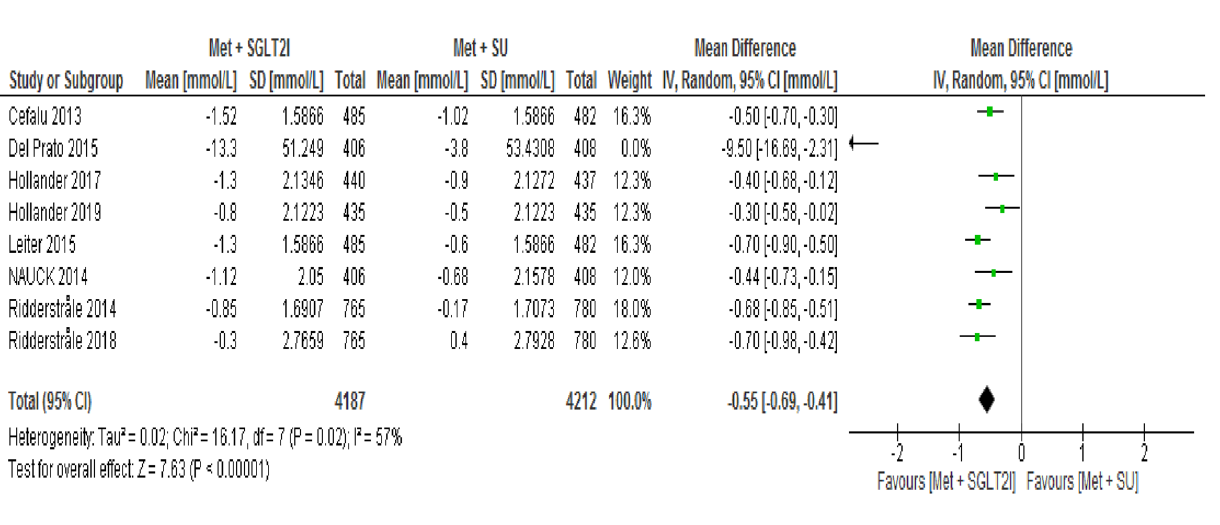
Figure 10. Comparison of change in body weight (Kg) from baseline between patients who were on metformin-SGIT2I and metformin-sulphonylureas combination therapies. SD standard deviation; CI confidence interval; MD = mean difference; Met metformin; SGLT2I sodium-glucose co-transporter 2 inhibitor; SU sulfonylurea.